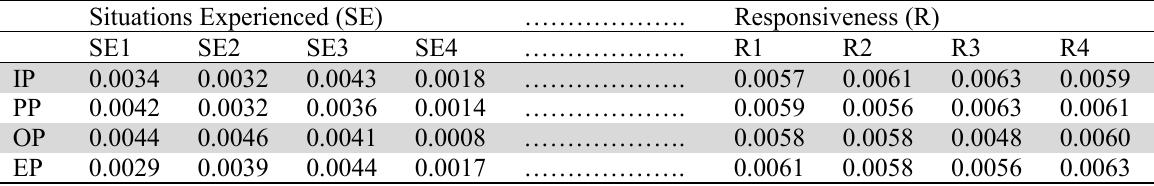
Showing Weighted Normalized Situations Experienced (SE)